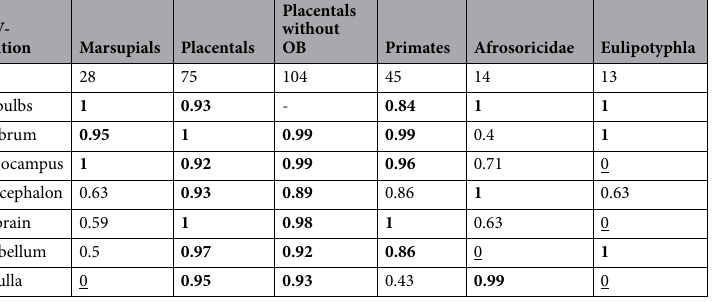
Table 5. Pagel’s λ of phylogenetic generalized least squares analyses of partition volume against whole brain volume minus partition volume. Bold, high lambda and similar W scores as a model with λ = 1; regular font, ambiguous; underlined, low λ and similar W scores as a model with λ = 0 (see materials and methods for